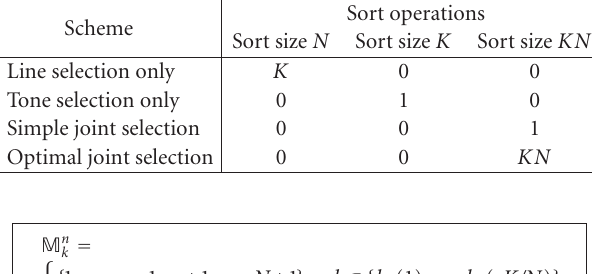
Table 2: Initialization complexity (sort operations) of partial can- cellation algorithms (per user).